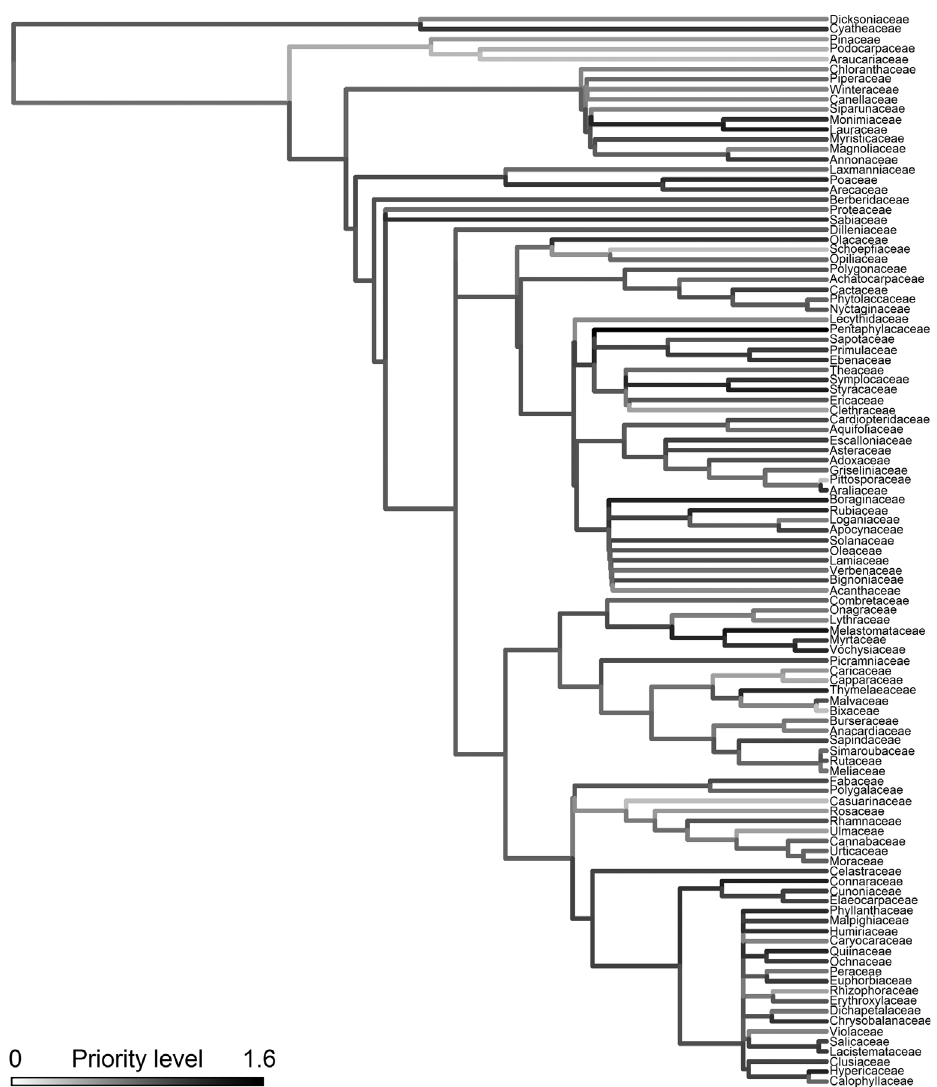
Figure 2 - The sampling priority level in future sequencing for each family of the SP tree flora, plotted against its phylogenetic hypothesis. The priority level was defined based on the representativeness of DNA barcodes within the family and the proportion of threatened and endemic species without